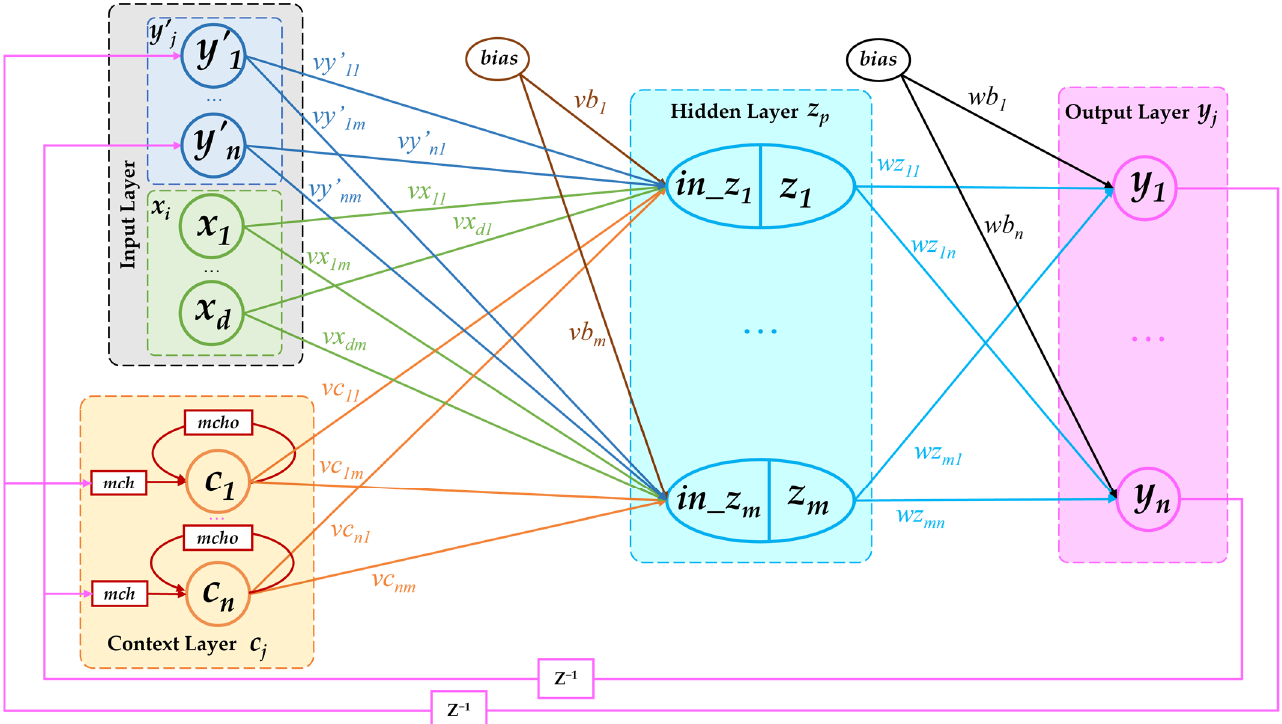
Figure 5. Detailed configuration of MJNN.